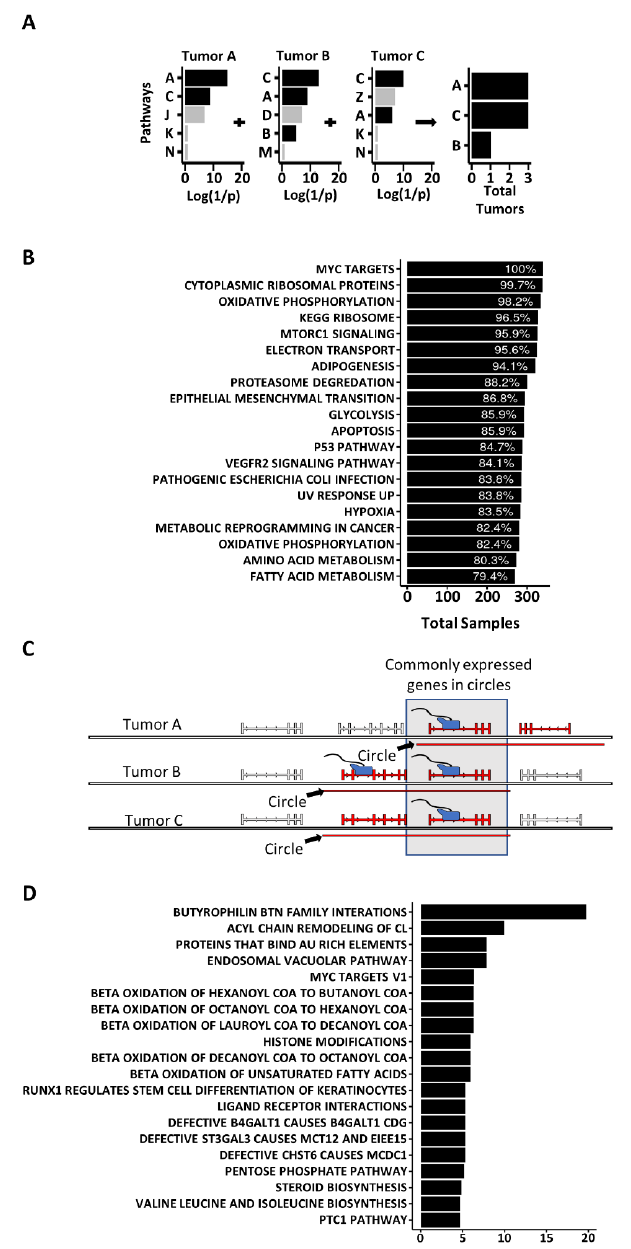
Figure 3. The circle-associated transcriptome is enriched with cancer-related pathways. ( A ) Schematic showing how commonly enriched pathways were defined. Pathway analysis was performed on the highest expressed genes in each tumor, defined as any gene with an FPKM value greater than one standard deviation above the mean. The common, significantly enriched pathways (in black) were then tallied across tumors and displayed as a waterfall plot. ( B ) Commonly enriched pathways in the circle-associated transcriptome. The percent of tumors with a significant enrichment of a specific pathway is indicated in white lettering inside each bar, while the length of each bar indicates the absolute number of samples with a significant enrichment (see Methods). ( C ) Schematic showing the isolation of genes commonly found in circles, prior to pathway enrichment. Expressed genes found in circles were isolated for each individual tumor. The number of tumors that expressed a gene located in a circle was totaled for all genes. ( D ) Pathways common to genes found in circles in greater than 50% of tumors. The length of the bar is the log10(1/ p -value). Significance for enrichment was determined using a modified Fisher’s exact text with a p -values less than 0.05 considered